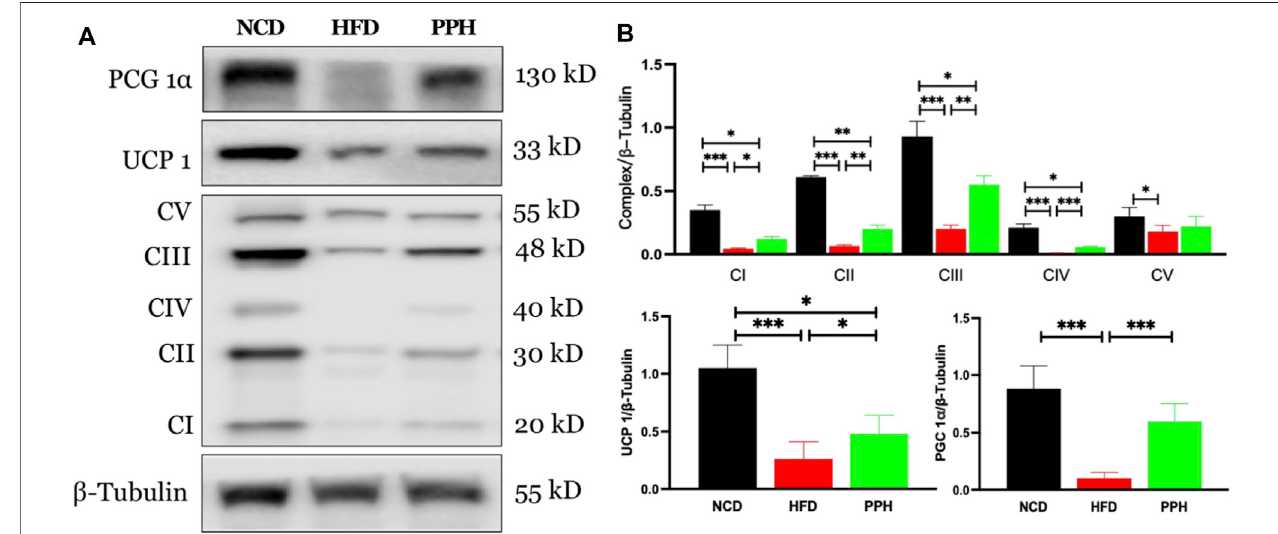
FIGURE6| EffectsofPPHonactivatingthemitochondrion-relatedsignalingpathwayinscapularadiposetissue.WesternblottinganalysesofPGC1 α ,UCP1,and mitochondria complex protein expression (A) ; Quanti fi cation of the PGC 1 α / β -Tubulin ratio, UCP 1/ β -Tubulin ratio, and mitochondria complex/ β -Tubulin ratio (B) . CI: complex I; CII: complex II; CIII: complex III; CIV: complex IV; CV: complex V. * p < 0.05, ** p < 0.01, and *** p < 0.001.